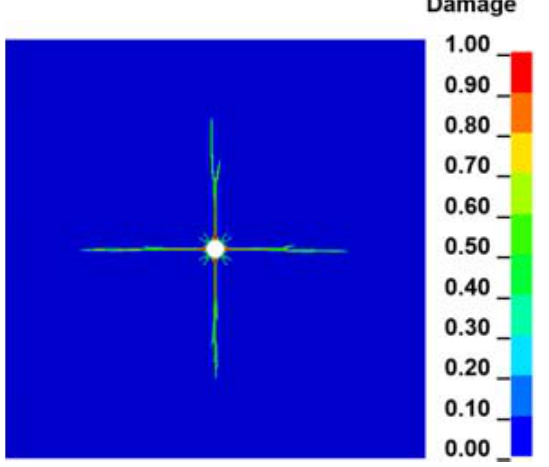
Figure 17. Coal crack propagation obtained from numerical simulation.